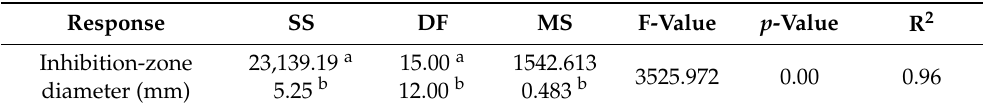
Table 8. ANOVA for the inhibition-zone diameter in the phase of RSM modeling of medium compo- sition using A. flavus SA2BSS as test